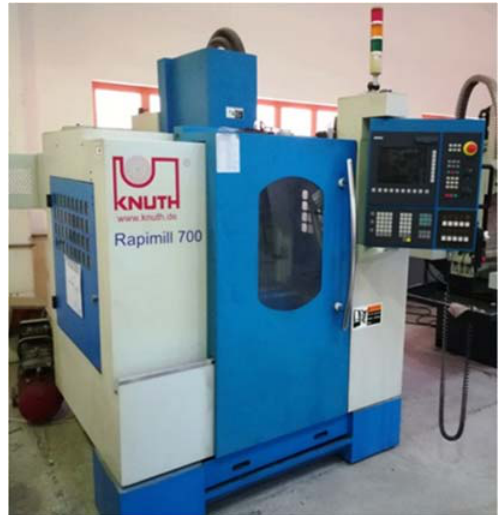
Fig. 3. CNC Vertical Milling Machine used in the experimental work.